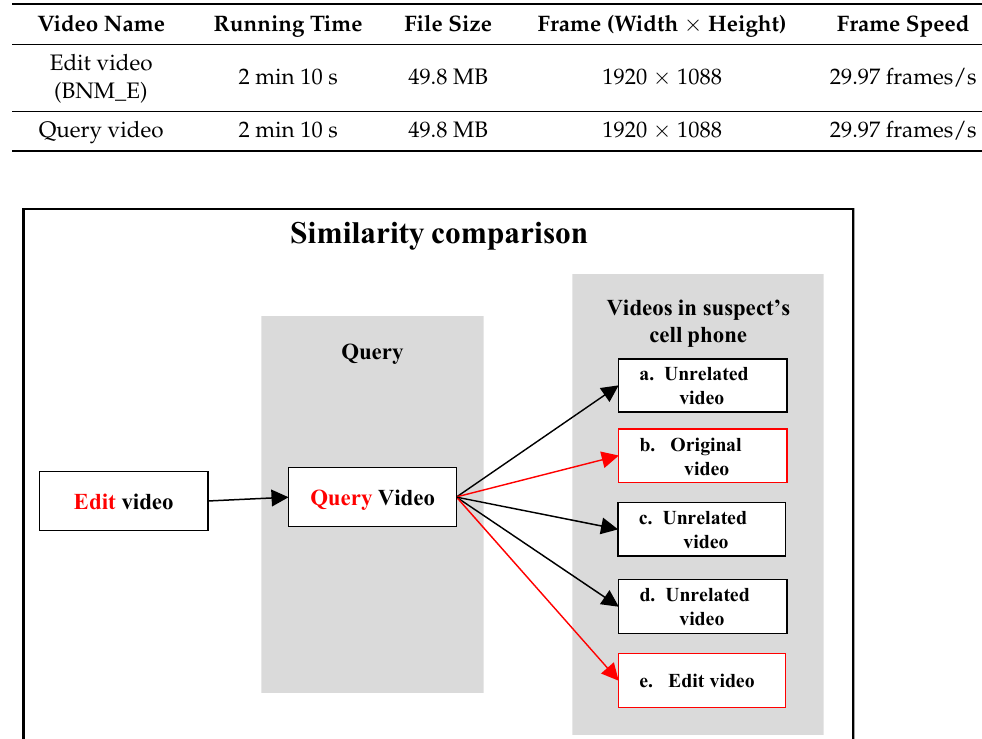
Table 7. Videos in suspect’s smart phone (scenario 1). Table 6. Video secured by investigators and query video (scenario 1).